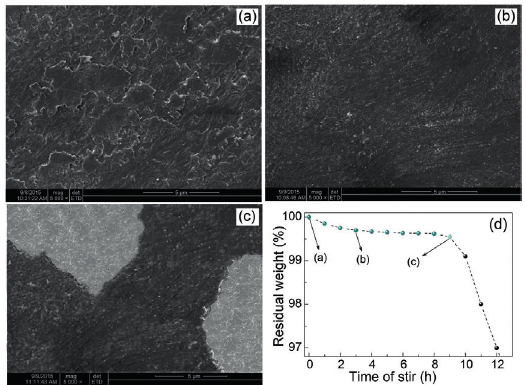
Figure 6: Effect of stirring time on residual weight of coated ferrosilicon particles. SEM micrographs of (a) t = 0 h, (b) t = 3 h and (c) t = 9 h.